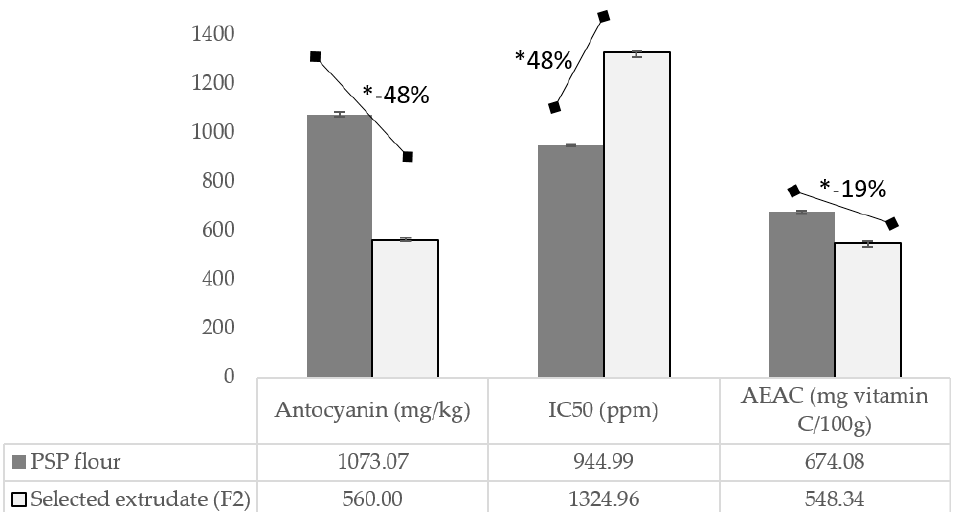
Figure 4. Profile of anthocyanin content, IC 50 , and AEAC of PSP flour and extruded PSP flour (selected formula: F2). * Significantly different at p < 0.05, analyzed using a t -test; F2, Formula with 40% substitution of kidney bean flour; IC 50 , the concentration of an antioxidant-containing substance required to scavenge 50% of the initial DPPH radicals; PSP, purple sweet potato; AEAC, Ascorbic Acid Equivalent Antioxidant Capacity.